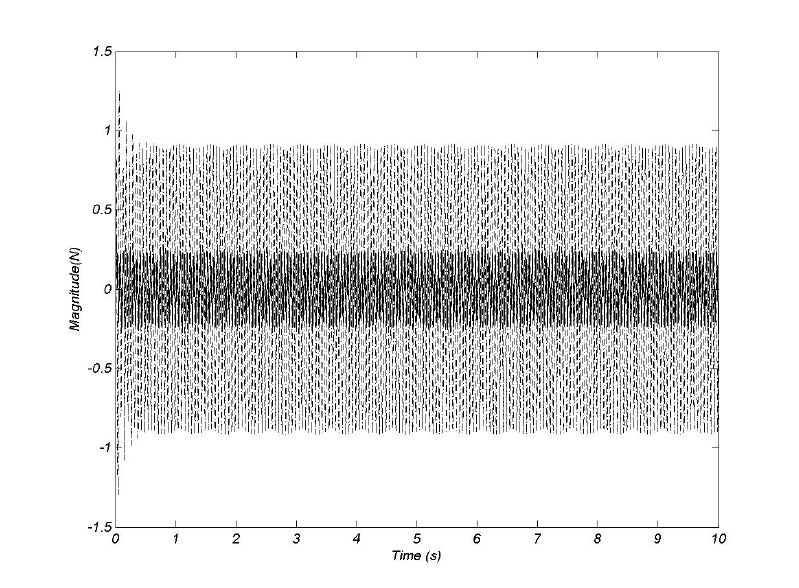
Fig. 18. Transmitted force variations of the system using the PD controller subjected to periodic engine disturbance at idling frequency. Open loop (–) and PD controlled (solid).